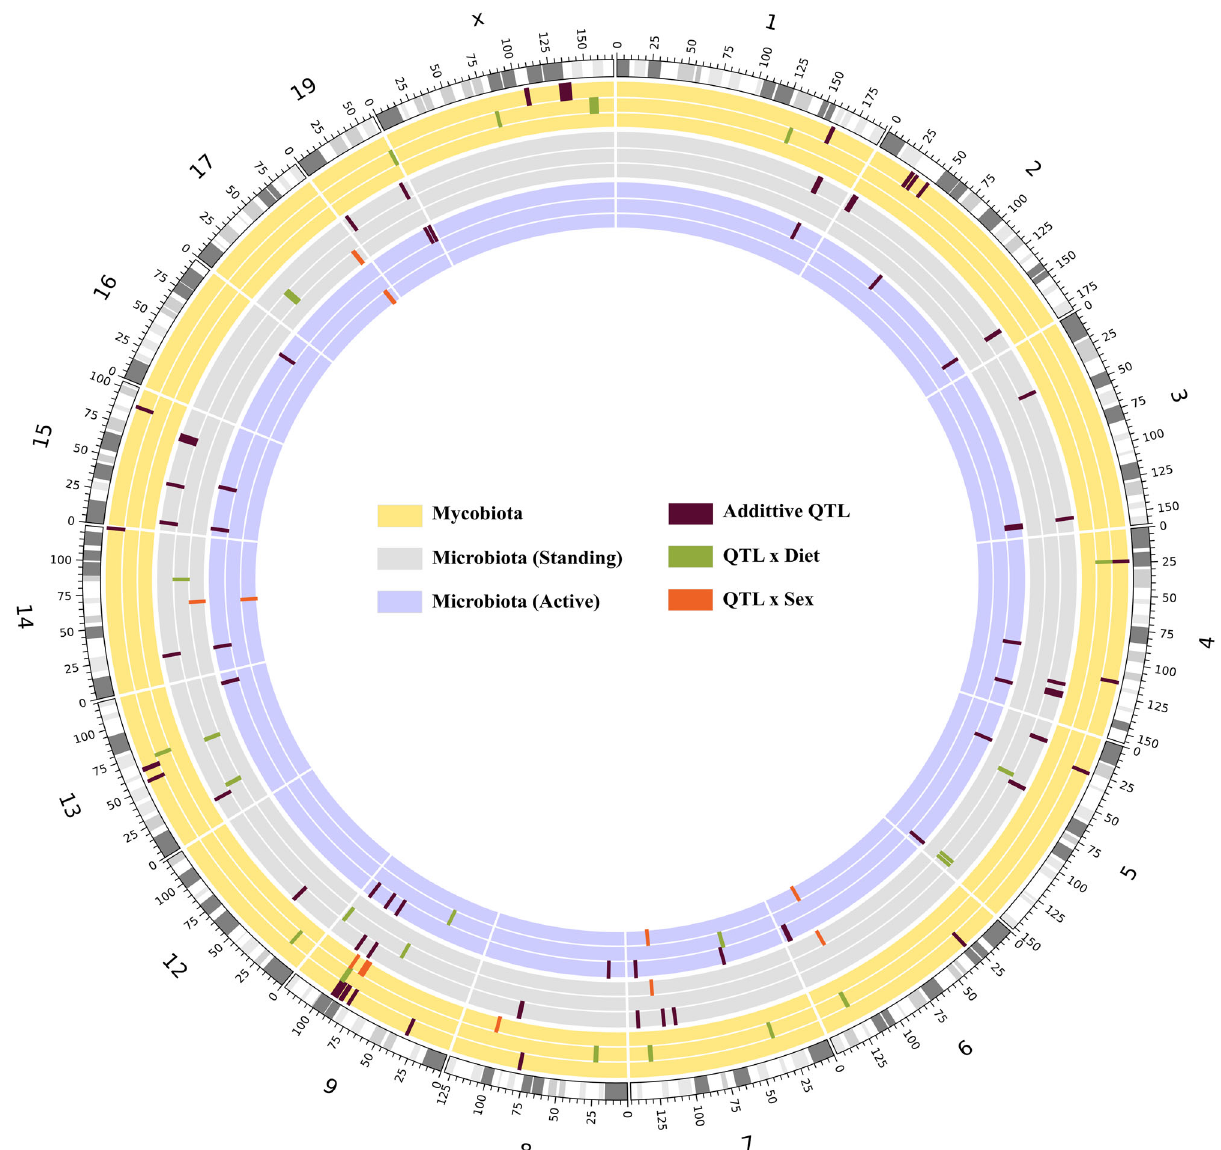
Fig. 4 | Gut fungal and bacterial QTL in AIL mice. Circos plot showing QTL ( α gw<0.05)inAIL mice associatedwith bacteria(standing and active community) andfungiastraits.Theoutermostcircleinthecircosplotdescribeschromosomes with cytogenic bands in the C57BL/6J mouse genome (reference mouse assembly mm10). Every circle within each chromosome is color coded for fungi (yellow), bacterial standing communities (gray) and bacterial active communities (purple)